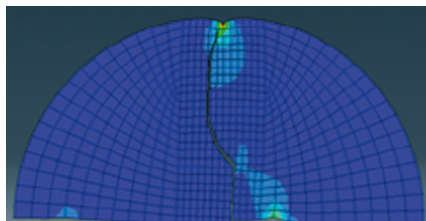
Figure 9: Distribution of stress and crack propagation path from XFEM.